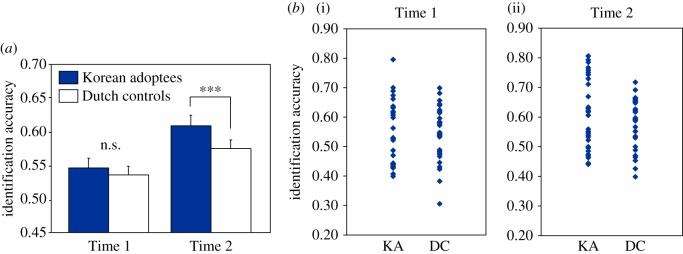
(a) Mean proportion of correct identification responses for Korean adoptees' versus Dutch controls' productions at Times 1 and 2 (error bars represent standard errors; ***p < 0.001) and (b) proportion of correct identification responses at individual speakers' first (i) and second (ii) production time points as a function of group (KA, Korean adoptees; DC, Dutch controls).